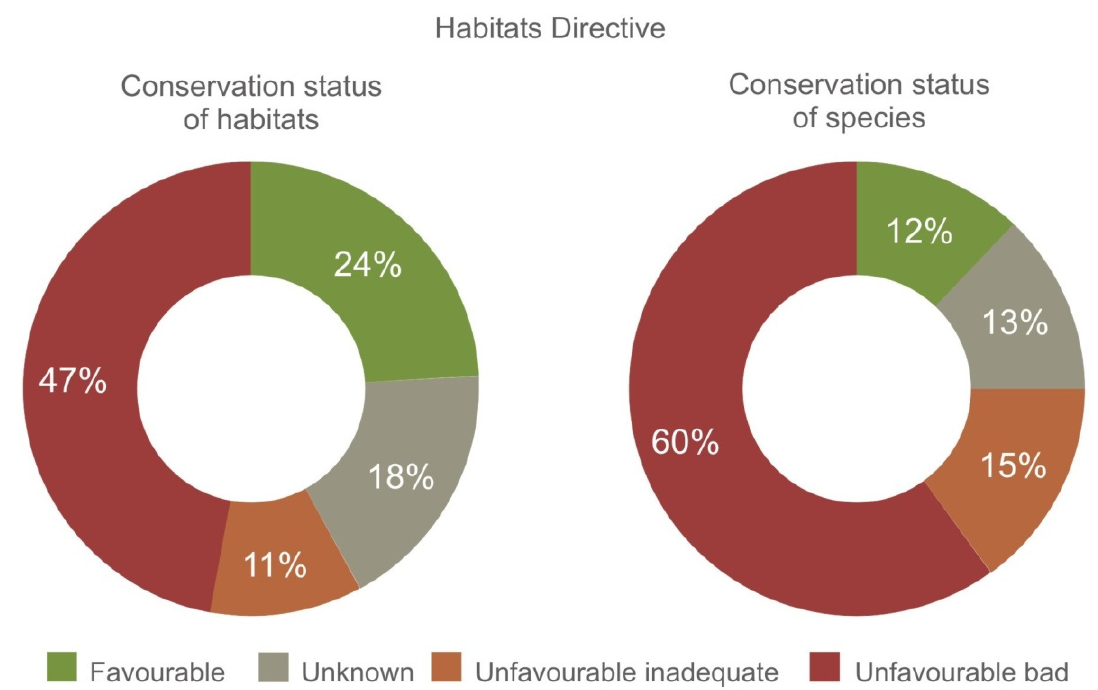
Figure 7. Conservation status of habitats and species under the Habitats Directive (2013–2018). Source: Sub-Directorate General for Biodiversity and the Natural Environment, Department of Territory and Sustainability, 2019.